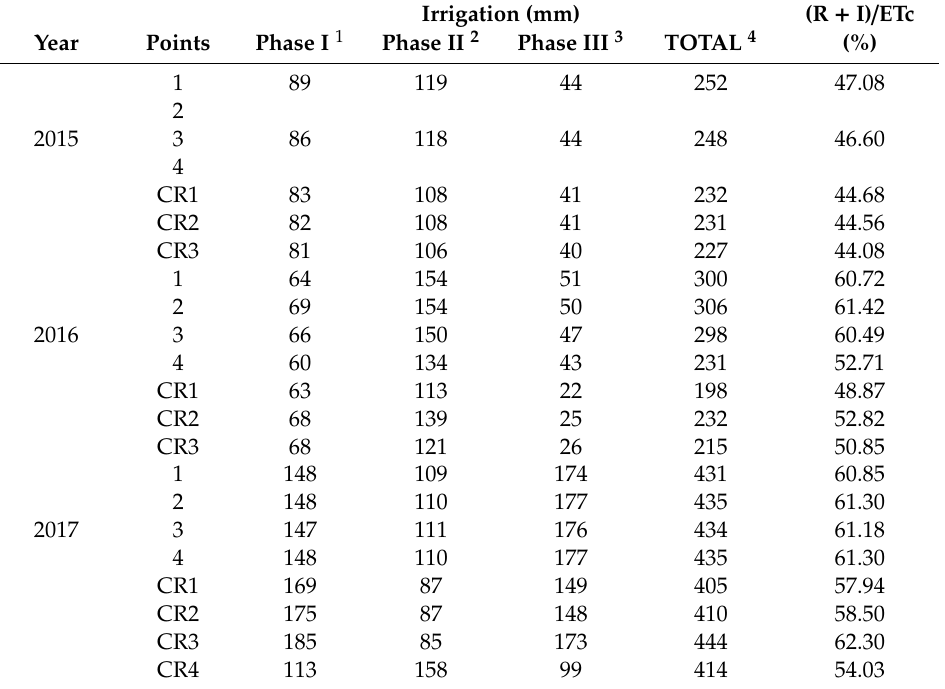
Table 4. Irrigation supplied at each sampling point in the three study